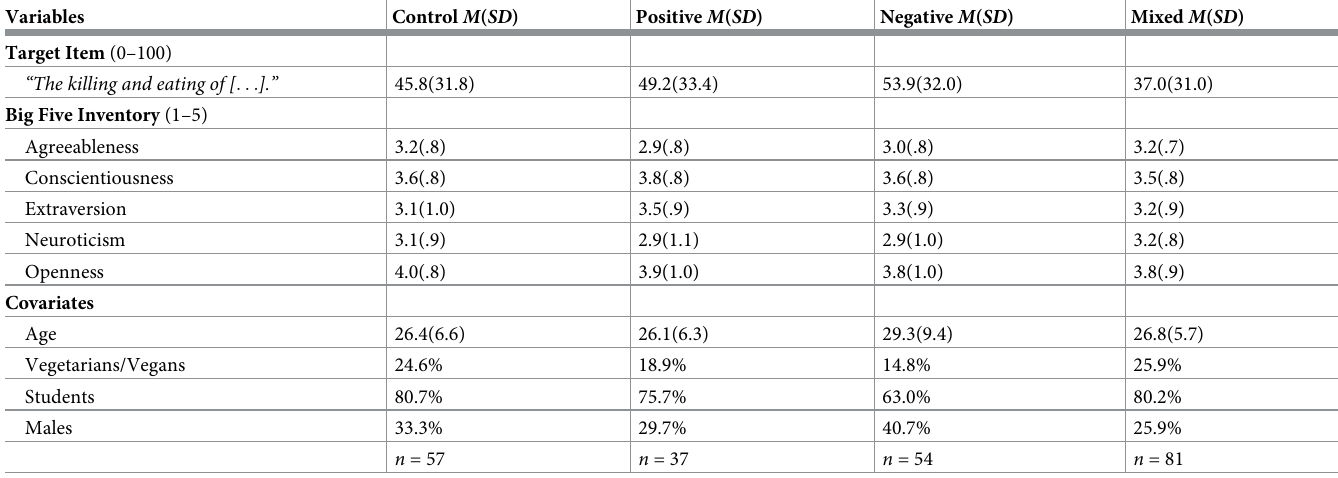
Table 3. Descriptive statistics (control vs. treatment groups, t 1